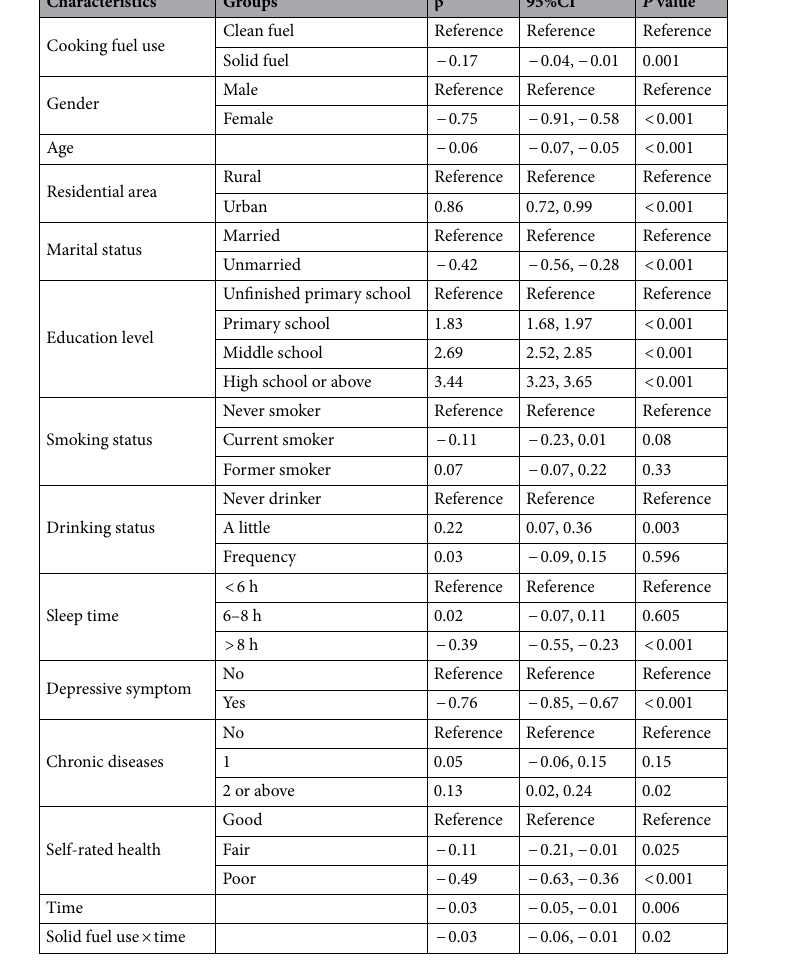
Table 2. Association of cognitive function with cooking fuel